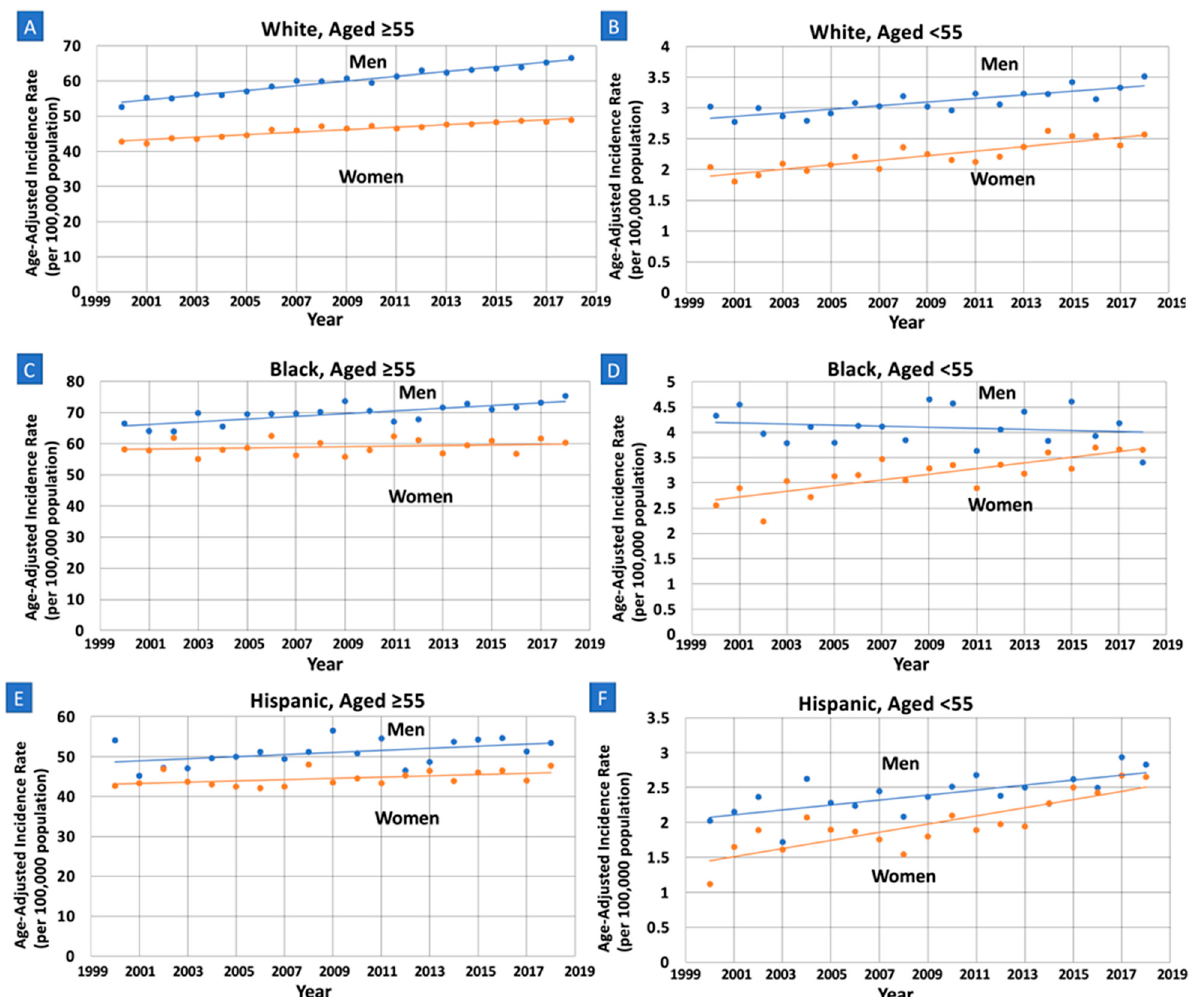
Figure 1. Sex-specific trends and age-adjusted pancreatic cancer incidence rates per 100,000 people among older (Age ≥ 55) and younger (Age < 55) White, Black and Hispanic adults. APC: annual percent change. ( A ): Older White: APC increasing at a lower rate in women compared to men (0.80 vs. 1.12, p = 0.001), with trends that are non-parallel ( p < 0.01) and non-identical ( p < 0.01). ( B ): Younger White: APC increasing at a greater rate in women compared to men (1.68 vs. 0.94, p = 0.010), with trends that are non-parallel ( p < 0.01) and non-identical ( p < 0.01). ( C ): Older Black: APC increasing at a lower rate in women compared to men (0.17 vs. 0.63, p = 0.026), with trends that are parallel ( p = 0.071) and non-identical ( p < 0.01). ( D ): Younger Black: APC increasing at a greater rate in women compared to men (1.74 vs. − 0.22, p < 0.001), with trends that are non-parallel ( p < 0.01) and non-identical ( p < 0.01). ( E ): Older Hispanic: APC neither increasing or decreasing in women and men, no significant difference (0.38 vs. 0.51, p = 0.65). ( F ): Younger Hispanic: APC increasing at a greater rate in women compared to men (3.03 vs. 1.48, p = 0.011); trends are non-parallel ( p < 0.01) and non-identical ( p <